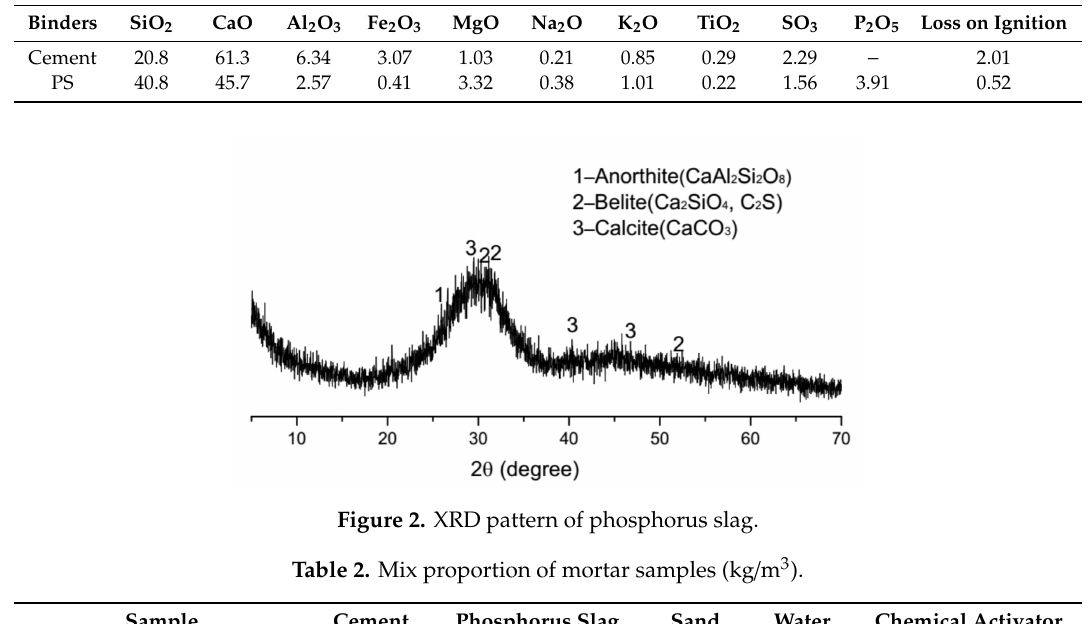
Table 1. Chemical compositions of P.O.42.5 cement and phosphorus slag (wt %).